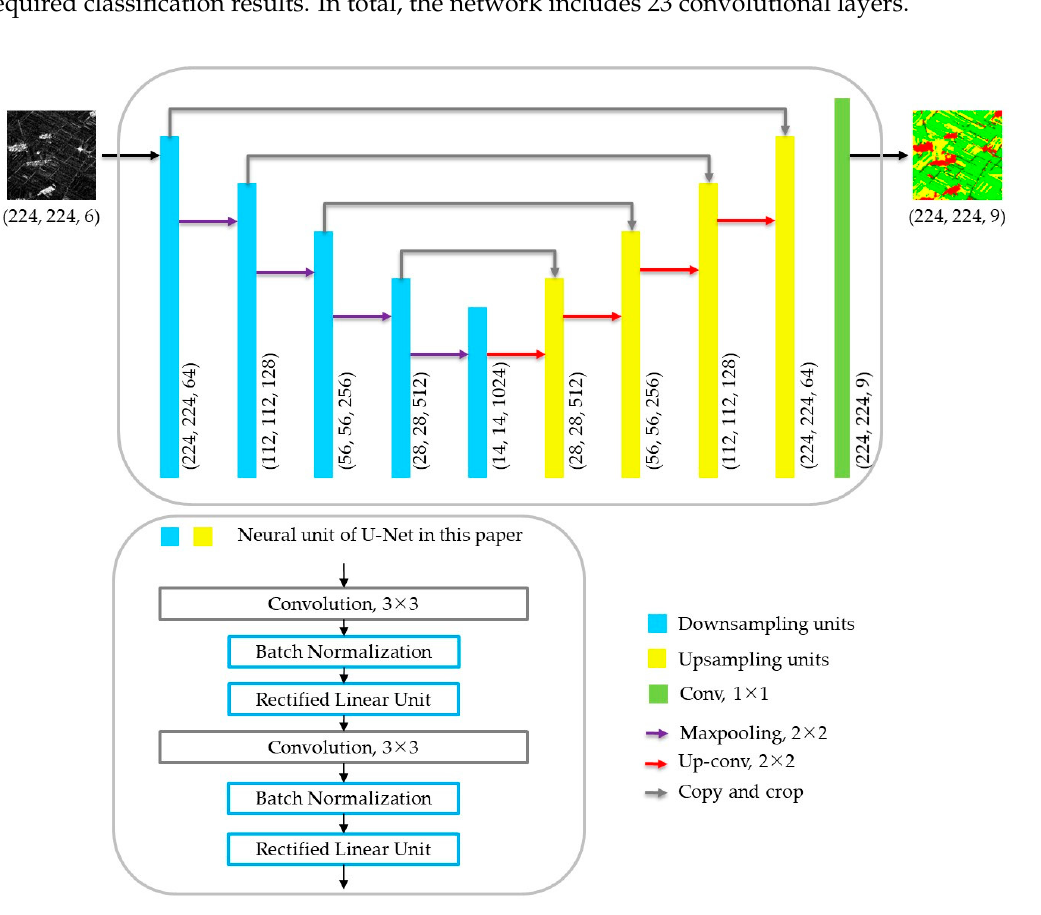
Figure 2. The U-Net architecture of this paper. Compared with U-Net [31], batch normalization algorithm is introduced to every convolution to improve the network training efficiency.